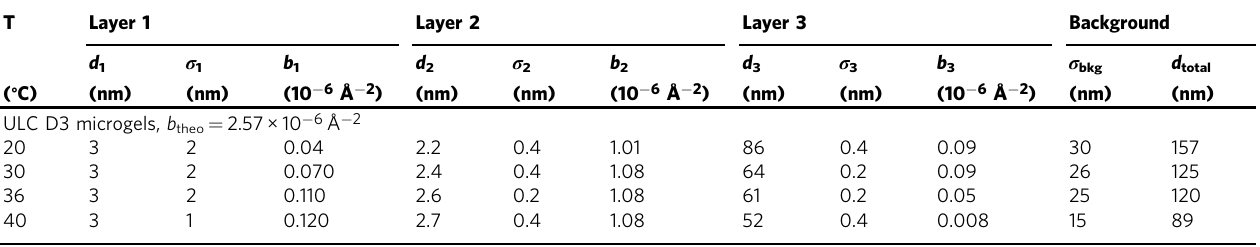
Table 3 Summary of the model fi ts the re fl ectivity curves of the ULC D3 microgels in Fig. 4.